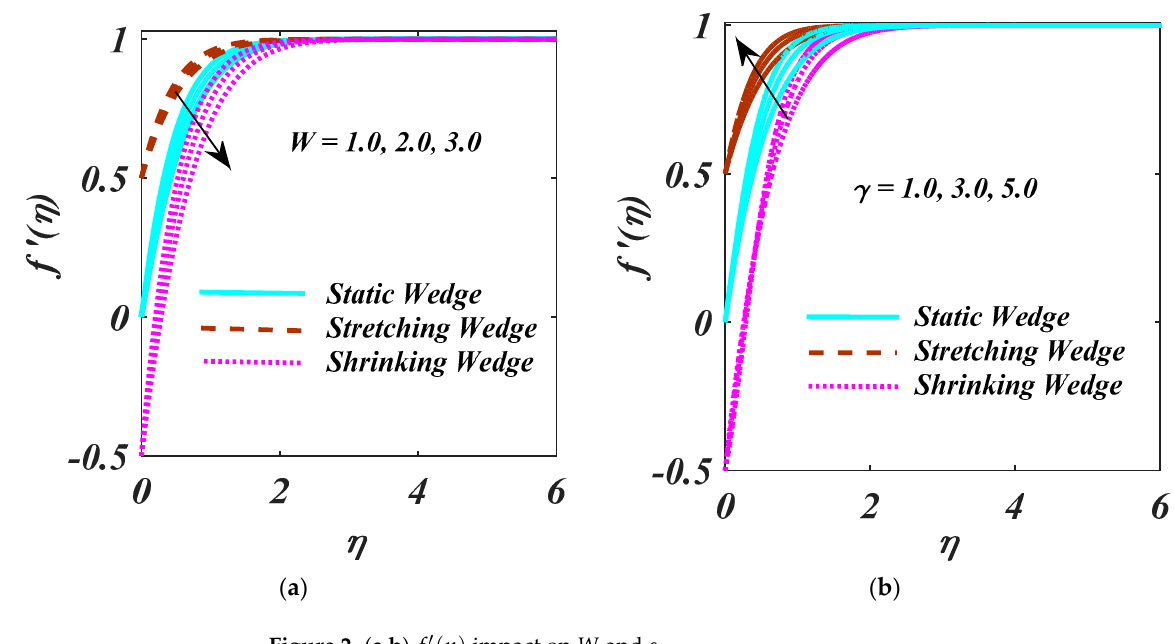
Figure 2. ( a , b ) f (cid:48) ( η ) impact on W and γ . Figure 3a,b illustrates how Fr and κ affect the velocity field. It is investigated whether the velocity field exhibits a decelerating trend as the variances Fr are increased. This is because the greater values of Fr produce resistance in a liquid flow, which reduces the velocity. The impact of the κ on the velocity distribution is elucidated in Figure 3b. The liquid’s velocity shrinks on more valuations of the κ . Due to the existence of a permeable medium, the liquid’s motion is halted, which causes a fall-off in liquid velocity.